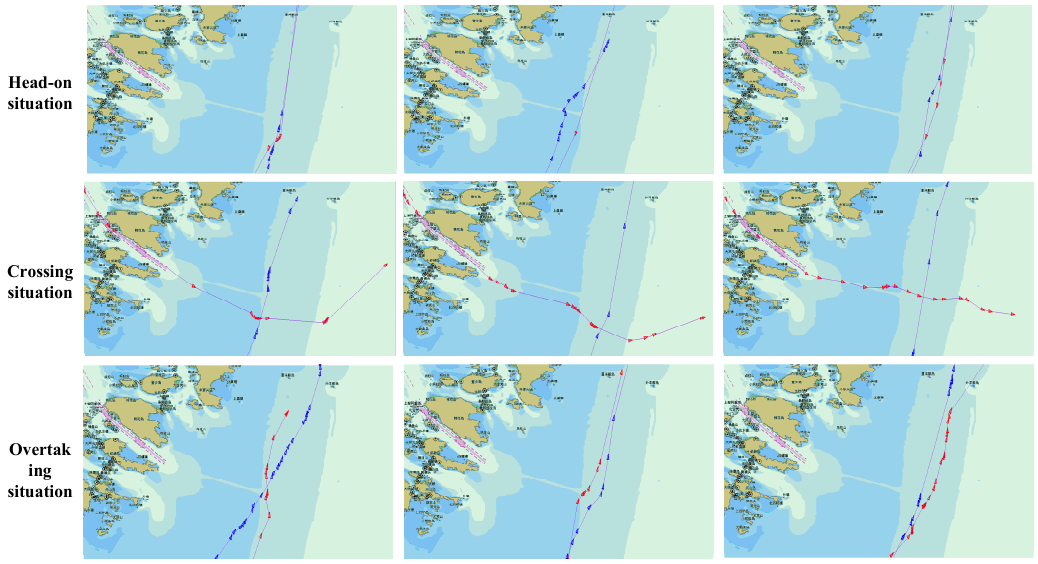
Figure 10. KFP sequence based on the ship-encounter AIS data.